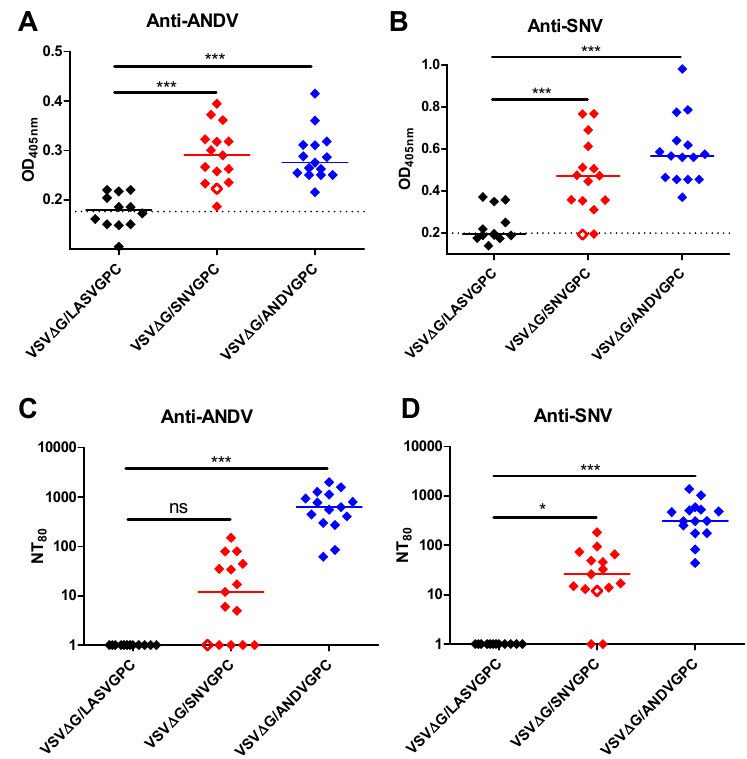
Figure 2. Humoral immune responses of vaccinated hamsters. Hamsters were vaccinated with either rVSV Δ G/LASVGPC ( n = 12), rVSV Δ G/ANDVGPC ( n = 15), or rVSV Δ G/SNVGPC ( n = 15) and IgG titers against either ( A ) ANDV or ( B ) SNV were assessed. NT80 against either ( C ) ANDV or ( D ) SNV was determined via microneutralization assay using recombinant VSV expressing either ANDV or SNV glycoprotein and GFP. Data medians are shown. Statistical significance was determined by one way ANOVA. *, p = <0.05; ***, p = <0.0001 . Empty diamond represents a hamster that succumbed to ANDV infection. Black diamonds are rVSV Δ G/LASVGPC vaccinated, red diamonds are or rVSV Δ G/SNVGPC vaccinated, and blue diamonds are rVSV Δ G/ANDVGPC vaccinated. To gain further insight into the mechanism of neutralization, we tested the neutralization activity of a selected set of sera on primary human endothelial cells (HUVEC), which model infection of the major targets of hantavirus infection in vivo. Sera from rVSV Δ G/ANDVGPC-immunized hamsters specifically neutralized ANDV GPC-mediated infection of HUVECs (Figure 3A) and also blocked binding of ANDV GPC to protocadherin-1 (PCDH1) (Figure 3B), the recently identified New World hantavirus receptor [22] suggesting that neutralizing antibodies block infection, at least partly, by preventing virus–receptor recognition.